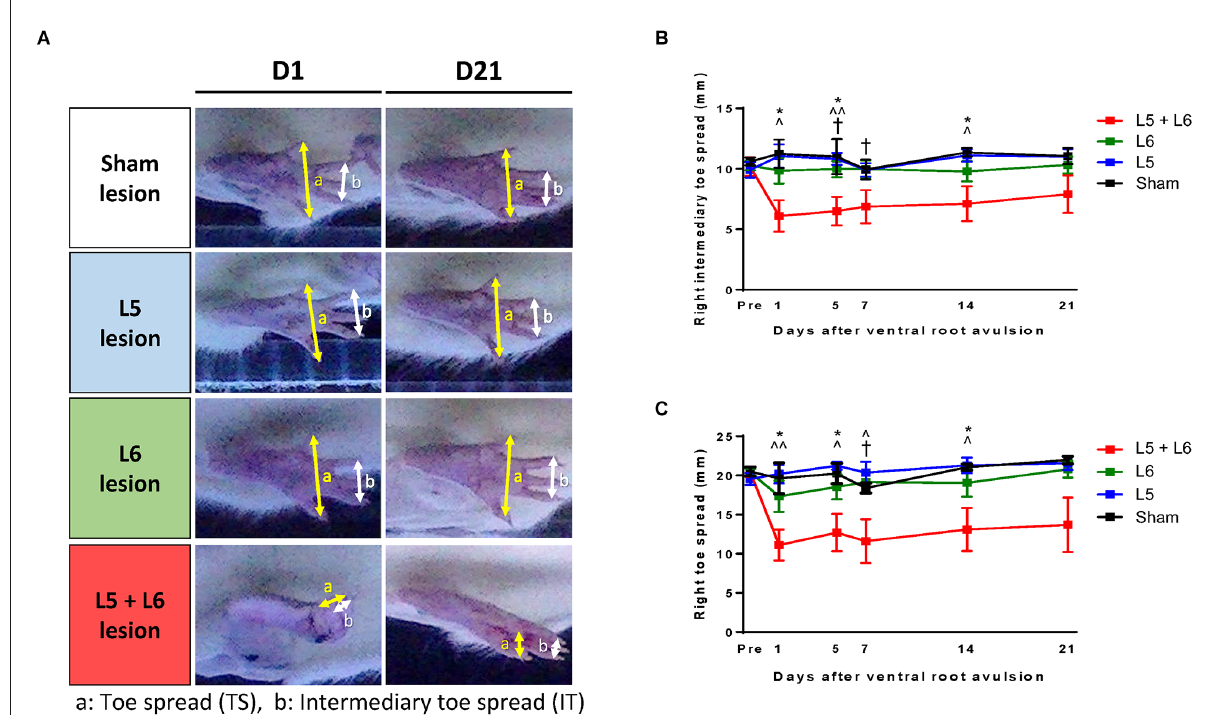
FIGURE4 Characteristics of the stepping footprint during locomotion of post-lesion rats (A) . (a) Toe spread (distance between first and fifth toes) was obtained from the bottom view of the walkway (b) Intermediary toe spread (distance between the second and fourth toes) was obtained from the bottom view of the walkway. The time-course changes in the right intermediary toe spread (B) and right toe spread (C) of each group. Note that the footprints in L5 + L6 ventral root avulsion rats clearly demonstrated a shorter toe spread (approximately 11.61 mm ± 2.79 mm) and an intermediary toe spread (approximately 6.88 mm ± 1.37 mm) compared to the other three groups and this was maintained for the full 21 days of our observation period. * p < 0.05, ** p < 0.01, *** p < 0.001 significant differences are shown between the sham and L5 + L6 groups. ∧ p < 0.05, ∧∧ p < 0.01, ∧∧∧ p < 0.001indicatesignificant posthoc Fisher’sLSDdifferenceswhencomparedbetweenL5lesionsandL5+L6lesions. † p < 0.05, †† p < 0.01, ††† p < 0.001 indicate significant post hoc differences between the L6 lesion and the L5 + L6 lesion